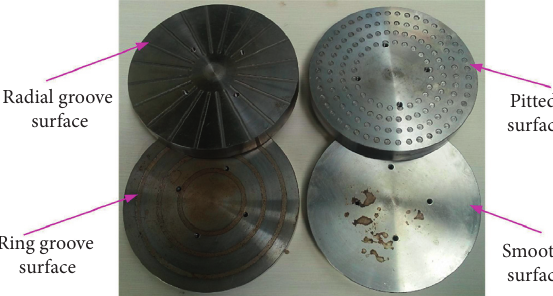
Figure 7: Drive plate with different surface topography.